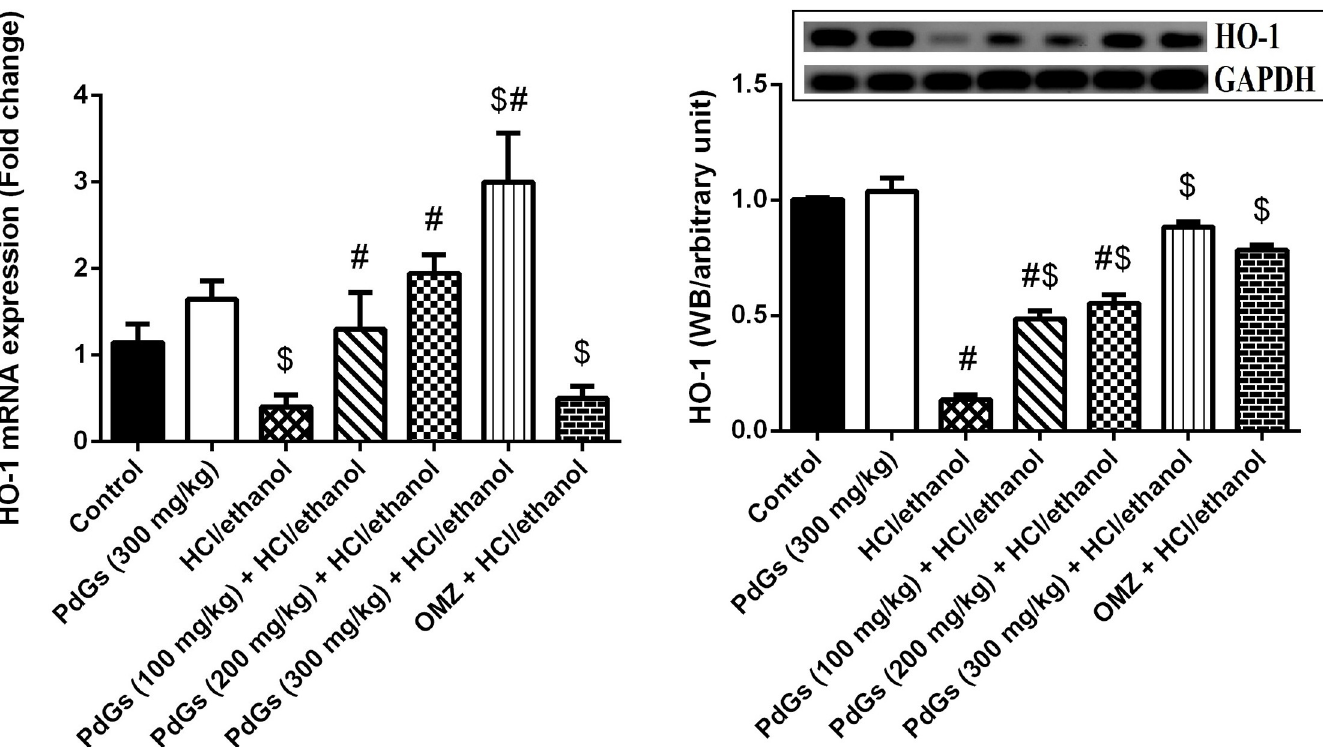
Fig 7. Effect of prodigiosins on the mRNA and protein expression of HO-1 in gastric tissue. Data (means ± SEM of three assays) were normalized to the levels of GAPDH and expressed as fold induction (log2 scale), relative to the level of HO-1 in the control. a P < 0.05, significant difference vs . the health rats; b P < 0.05, significant difference vs . HCl/ethanol-induced rats, Duncan’s post-hoc test.